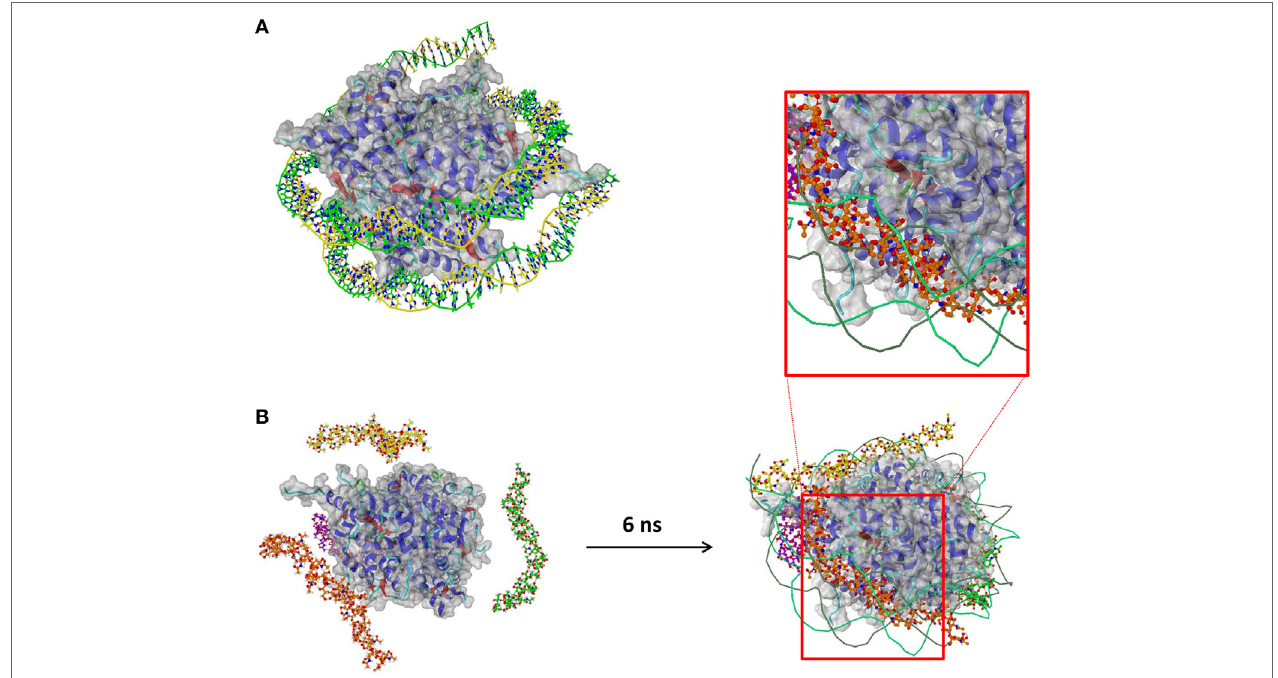
FigUre 2 | Molecular dynamics (MD) simulation of polySia chains and histone. (a) The histone part of this complex has been used as receptor in a docking study and an MD simulation after removing the DNA fragments (Histone–DNA complex, Protein Data Bank entry 3wa9). (B) Four chains of 20 sialic acids each have been placed close to the histone and put into a water box (water not shown). After 6 ns, the polySia chains have bound to the histone and moved to the areas that bind to